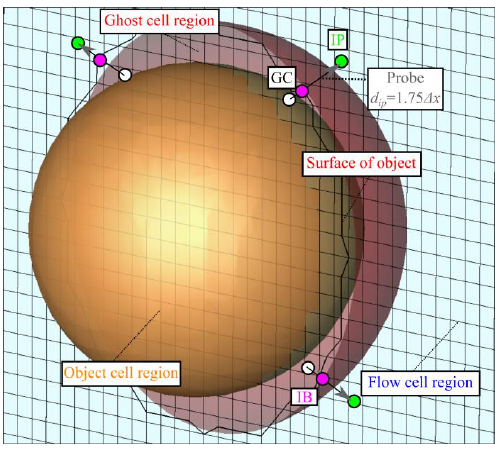
Figure 1. Domain around an object.